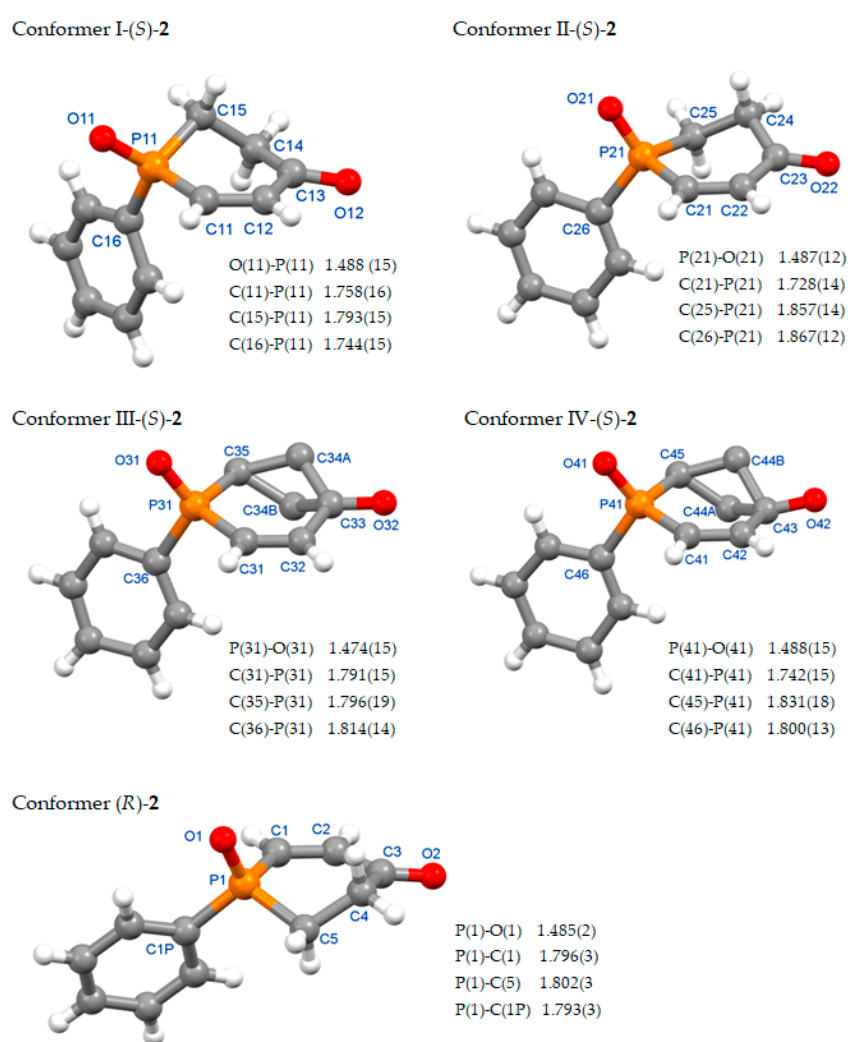
Figure 6. Perspective view of solid-state conformers observed for enantiomers S and R with bond lengths involving the P atom. The conformers III-( S )- 2 and IV-( S )- 2 are disordered. The conformational variation of the six-membered phosphinenone ring takes place by changing the position of the C sp3 -C sp3 atoms. In order to provide a complete description of the phosphinenone conformation, the specification of the endocyclic torsion angles within the rings was completed (Table 1). In the solid state, the ( S )- 2 molecules adopt six conformations that are in either a sofa or a half-chair formation. A ring substituent (phenyl group) at the phosphinenone unit can be either pseudoaxial or pseudoequatorial in the given conformer. The key parameter defining the orientation of the phenyl group in space are the exocyclic torsion angles, which are highlighted in green in Table 1. Interestingly, in the conformer I-( S )- 2, the phenyl group adopts an energetically unpreferred pseudoaxial position [24]. Figure 7a provides the molecular fitting for all conformers of the S enantiomer observed in the unit cell of its complex with ( R,R